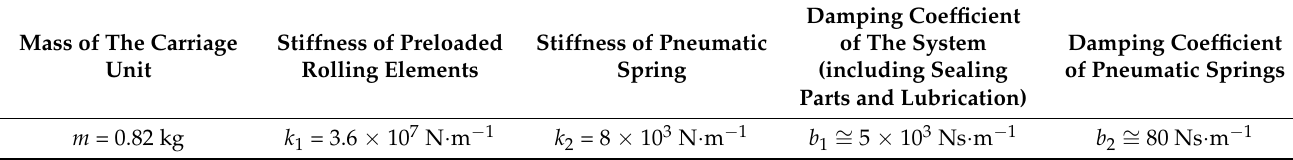
Table 4. Dynamical parameters of the simplified mechanical model in Figure 18.